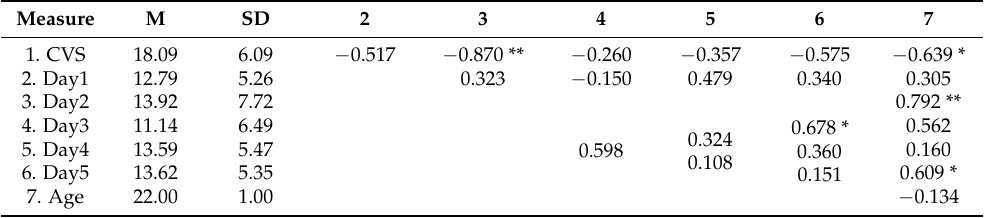
Table 5. Summary of Pearson’s